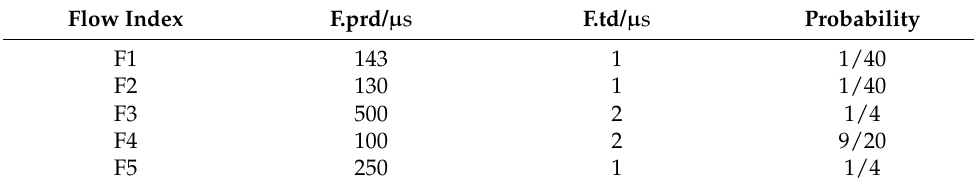
Table 4. Test group 3 of candidate